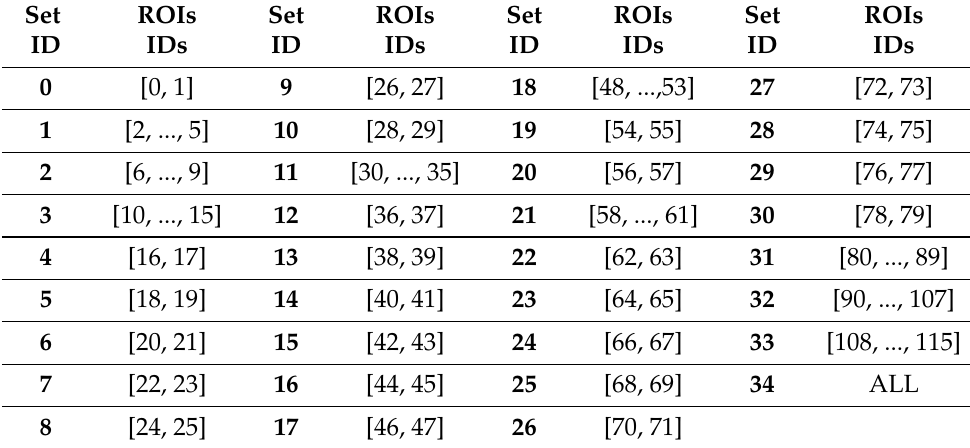
Table 8. SoRs IDs and their respective RoIs IDs from